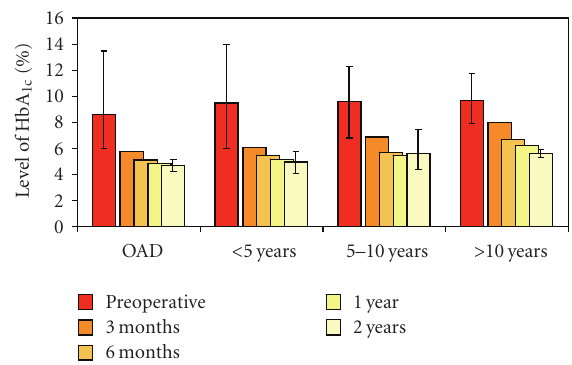
Figure 5: HbA 1c levels after BPD-DS dependent on preoperative duration of insuline usage. Group I “OAD” was treated by oral antidiabetic drugs only. HbA 1c levels were below 6% as early as 3 months after the operation. Group II used insulin for less than 5 years preoperatively and also showed normal levels of HbA 1c from 3 months after the operation on. Group III used insulin for 5 to 10 years. Mean HbA 1c normalized 6 months after the operation. Group IV used insulin for more than 10 years. Mean HbA 1c in this group normalized not until 2 years after the operation. Shown are mean values and additionally minimum/maximum values for preoperative and 2 years